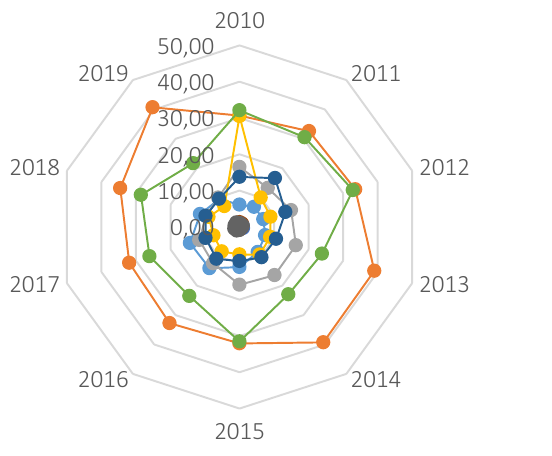
Figure 1. Dynamics of sectoral capital